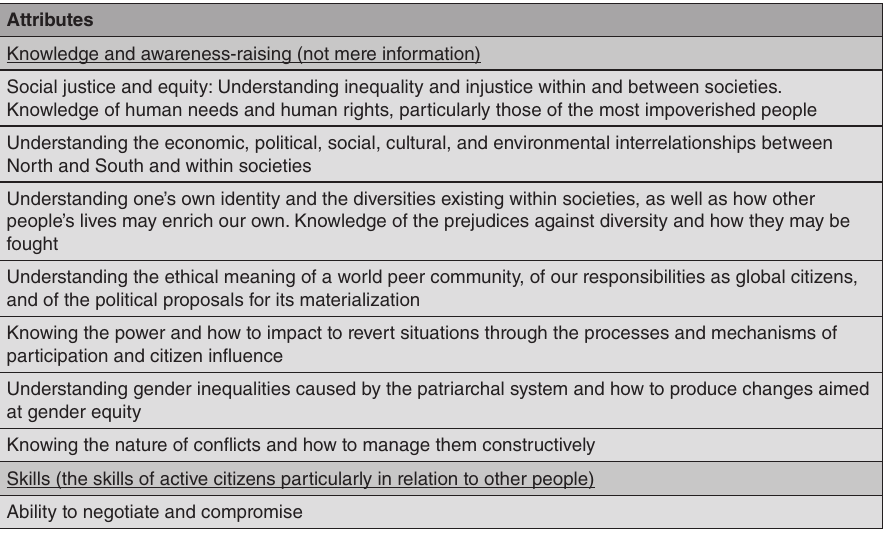
Figure 2: Attributes of global citizenship